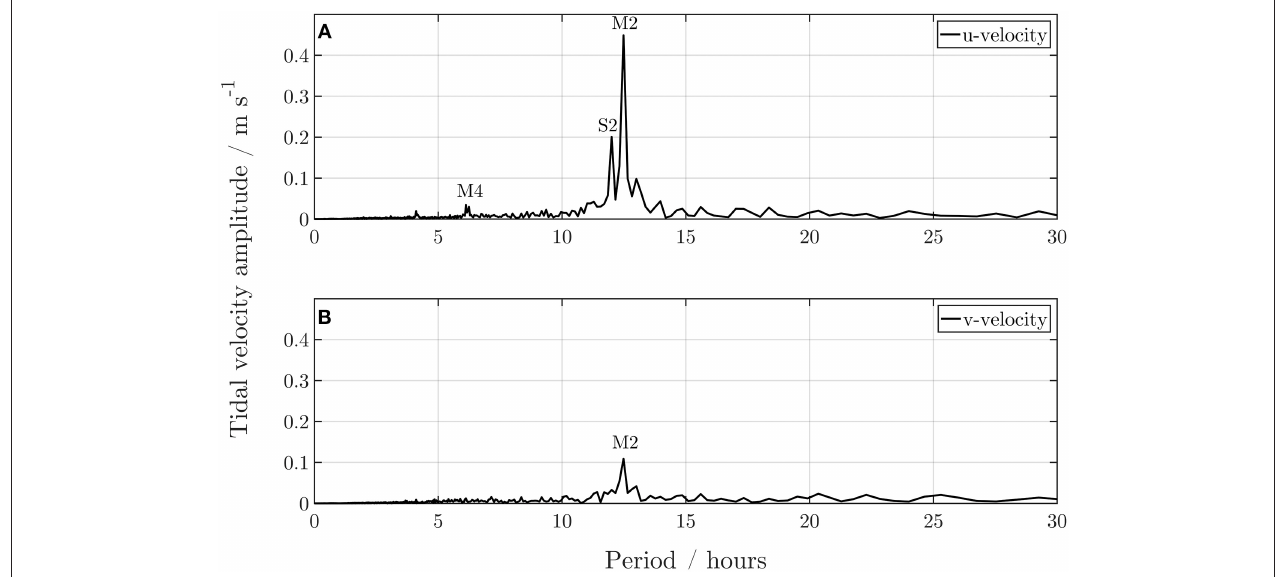
TABLE 1 | Summary of the drifter deployments in March and October 2017. Drifter Deployment date Deployment